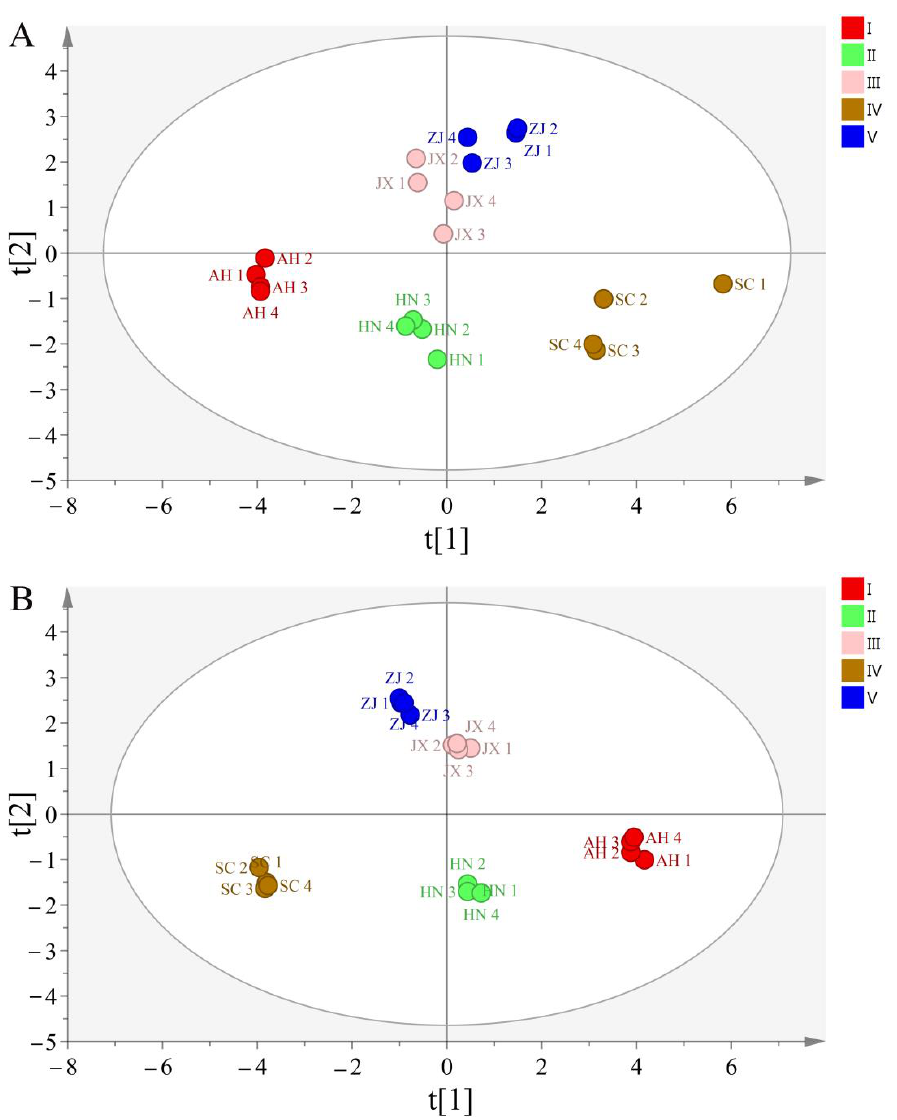
Figure 7. The PCA: principal component analysis ( A ) and OPLS-DA: orthogonal partial least-squares discriminant analysis ( B ) scores plot of 20 batches of Chansu samples based on peak area data of fourteen characteristic